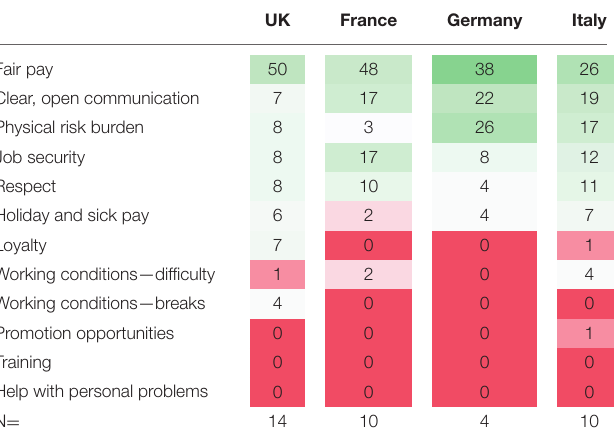
TABLE 3 | Analysis of protest